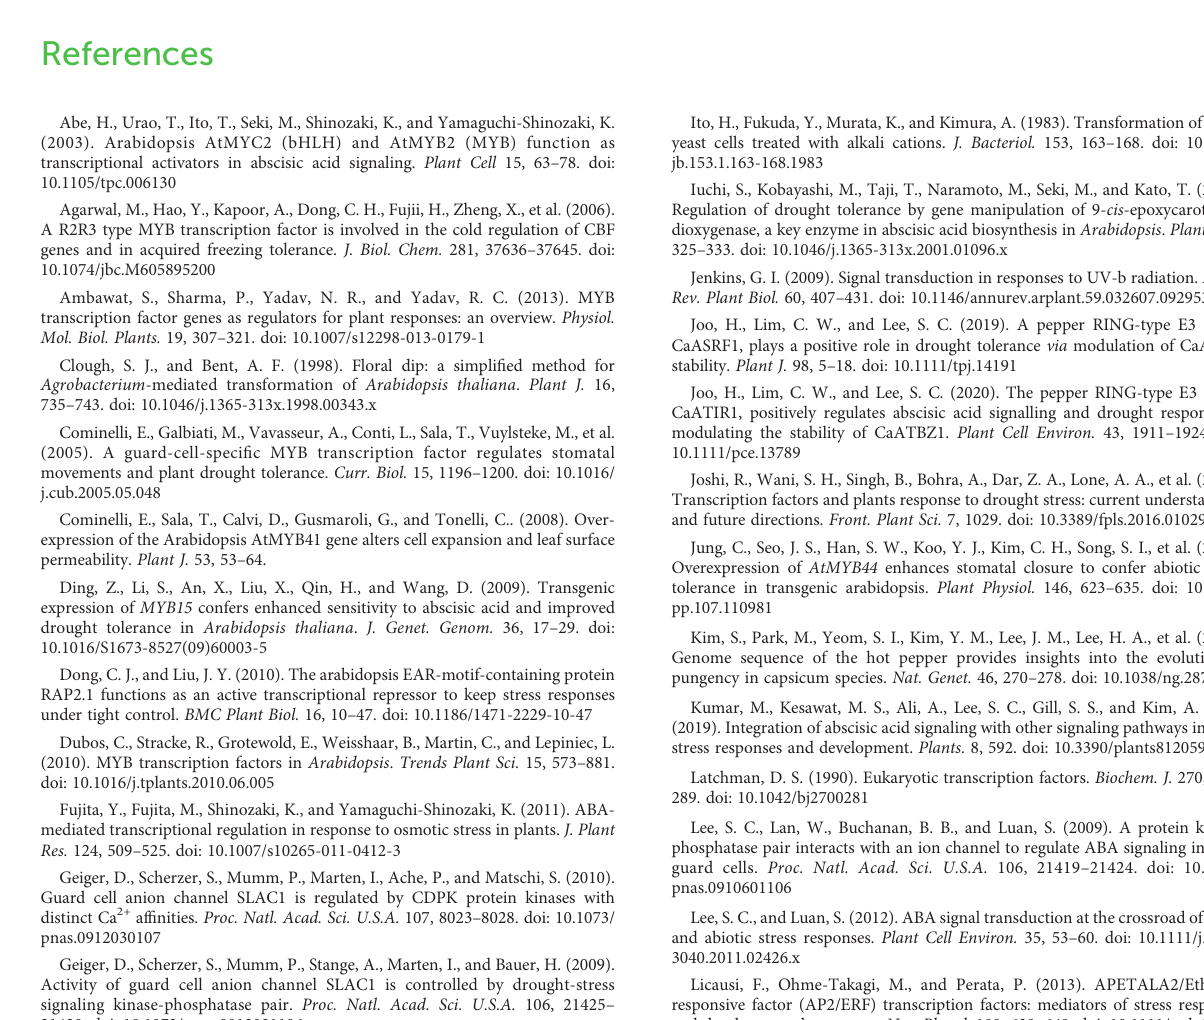
SUPPLEMENTARY TABLE 1 Sequences of primers used in this